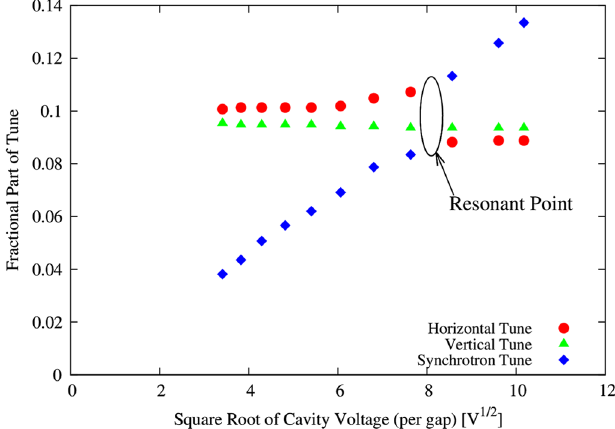
FIG. 3. Synchrotron and horizontal betatron coupling near the resonant point ¯ ν ¼ 0 . 10 ( ν β x ¼ 2 . 10 , ν s ¼ 0 . 10 , ν β z ¼ 1 . 10